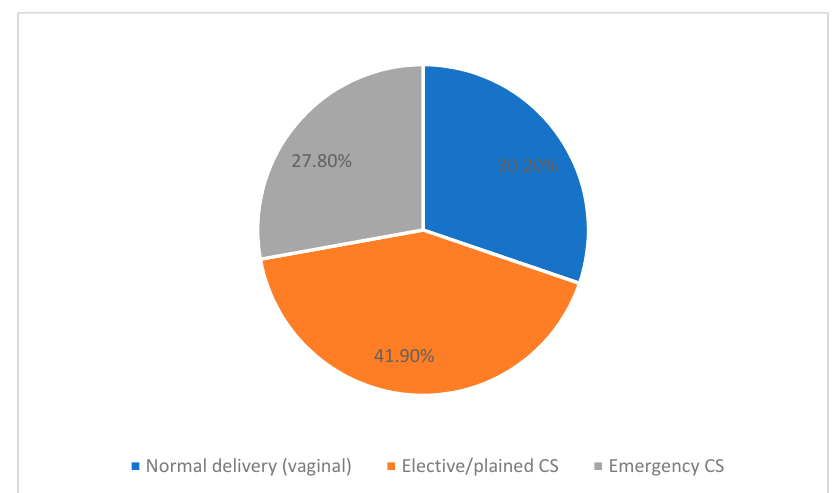
Figure 2. Frequency of delivery mode in the study participants . The higher CS frequency was significantly associated with the younger age category (20–24 years) and pre-term gestational age ( p = 0.03). Moreover, there was a high number of cesarean deliveries in females with low multi-parity ( p < 0.001). The details of socio- demographic association with the pattern of delivery are given in Table 1. Table 1. The association of demographic variables with the mode of delivery .